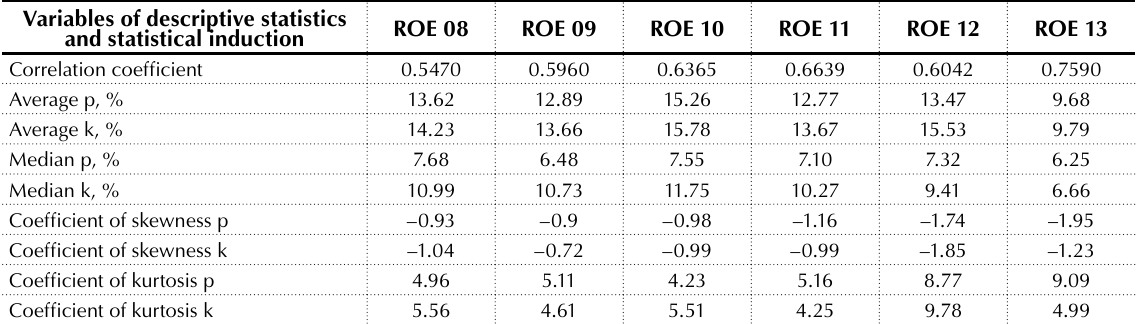
Table 2. Statistical values of ROE